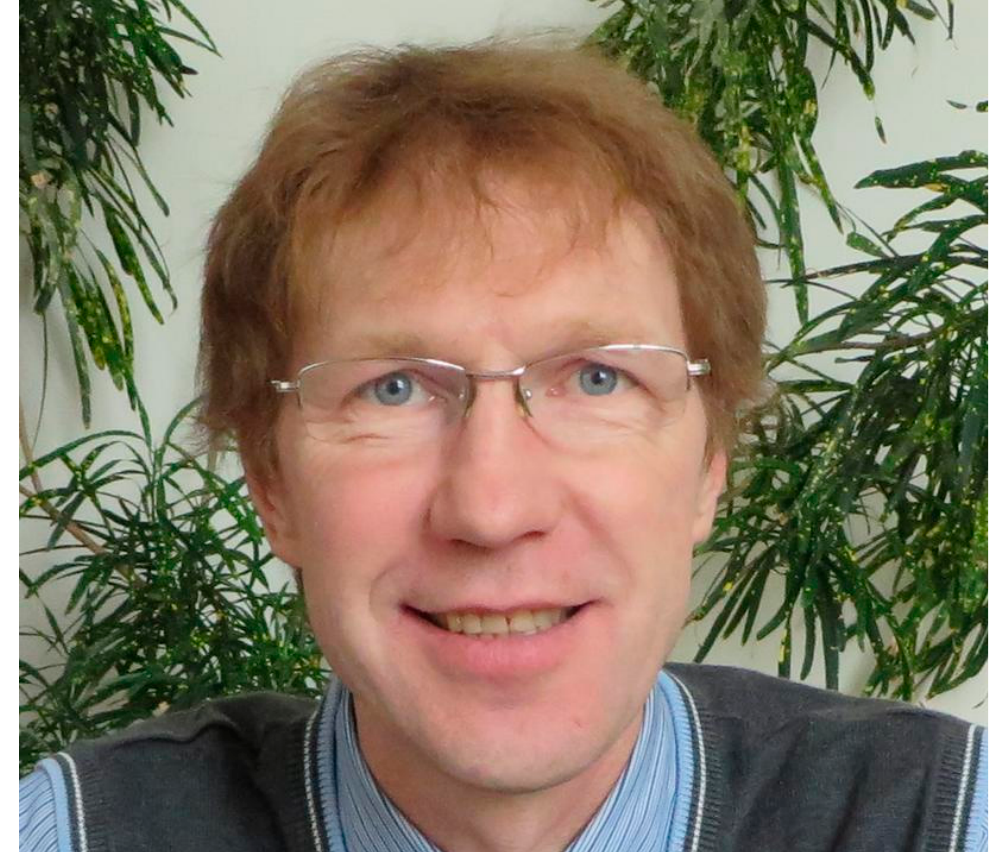
Figure 1. Dr. Konstantin Danilenko.